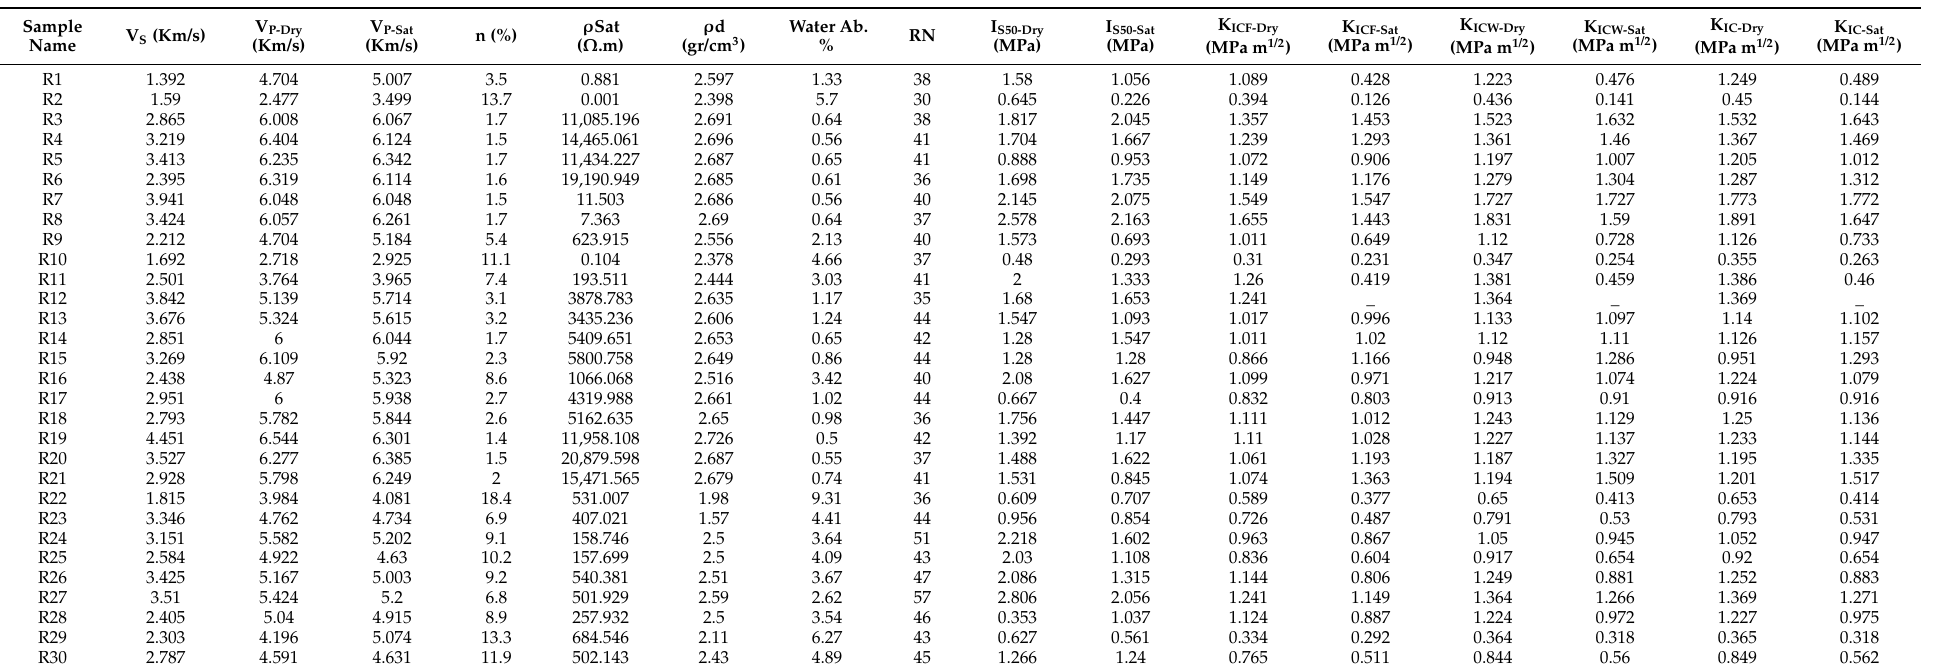
Table 3. Engineering characteristics of the studied